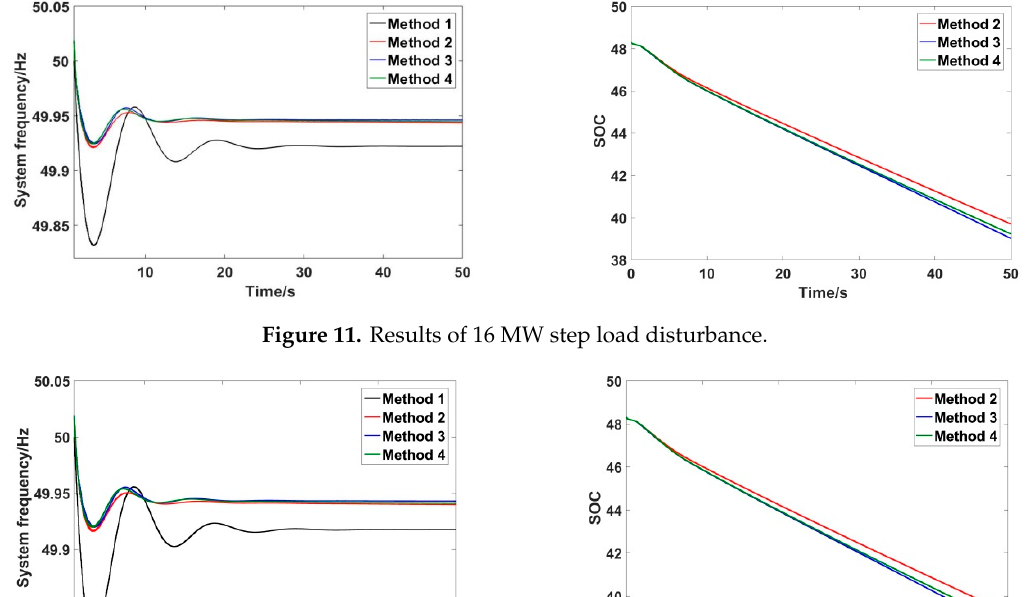
Figure 10. Results of 15 MW step load disturbance.